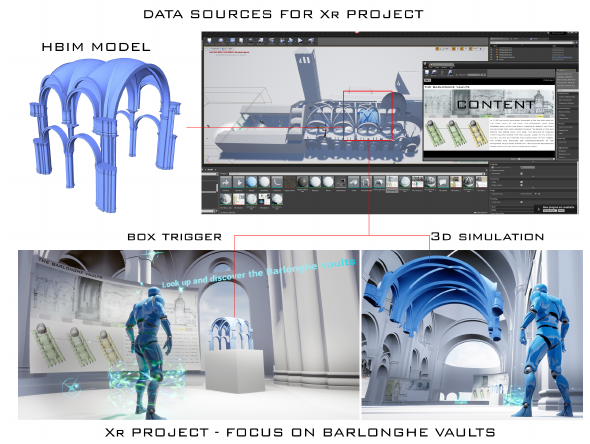
Figure 10. 3D simulation of the Barlonghe vaults in the Xr project. Box trigger function allows the interaction between the user and the interactive